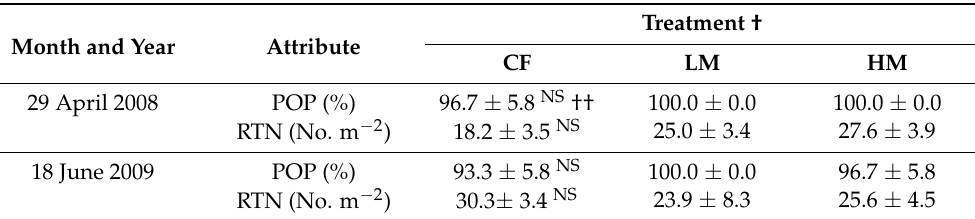
Table 3. Overwintering attributes of percentage of overwintering plants (POP) and regrown tiller density (RTN) of DL Napiergrass in the first and second years.